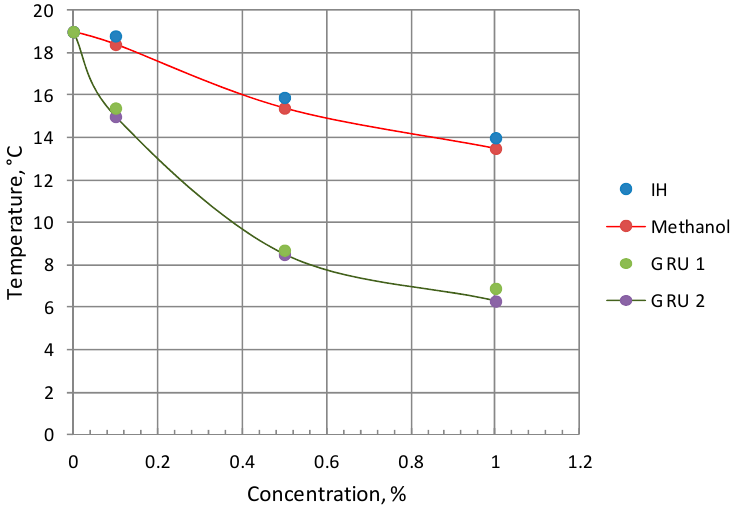
Figure 16. Dependence of the hydrate formation temperature on the inhibitor concentration in an isothermal experiment.